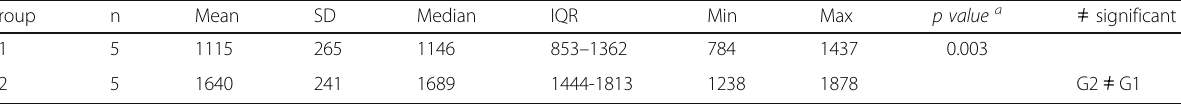
Table 5 Descriptive analysis of maximum load (in newtons) by group